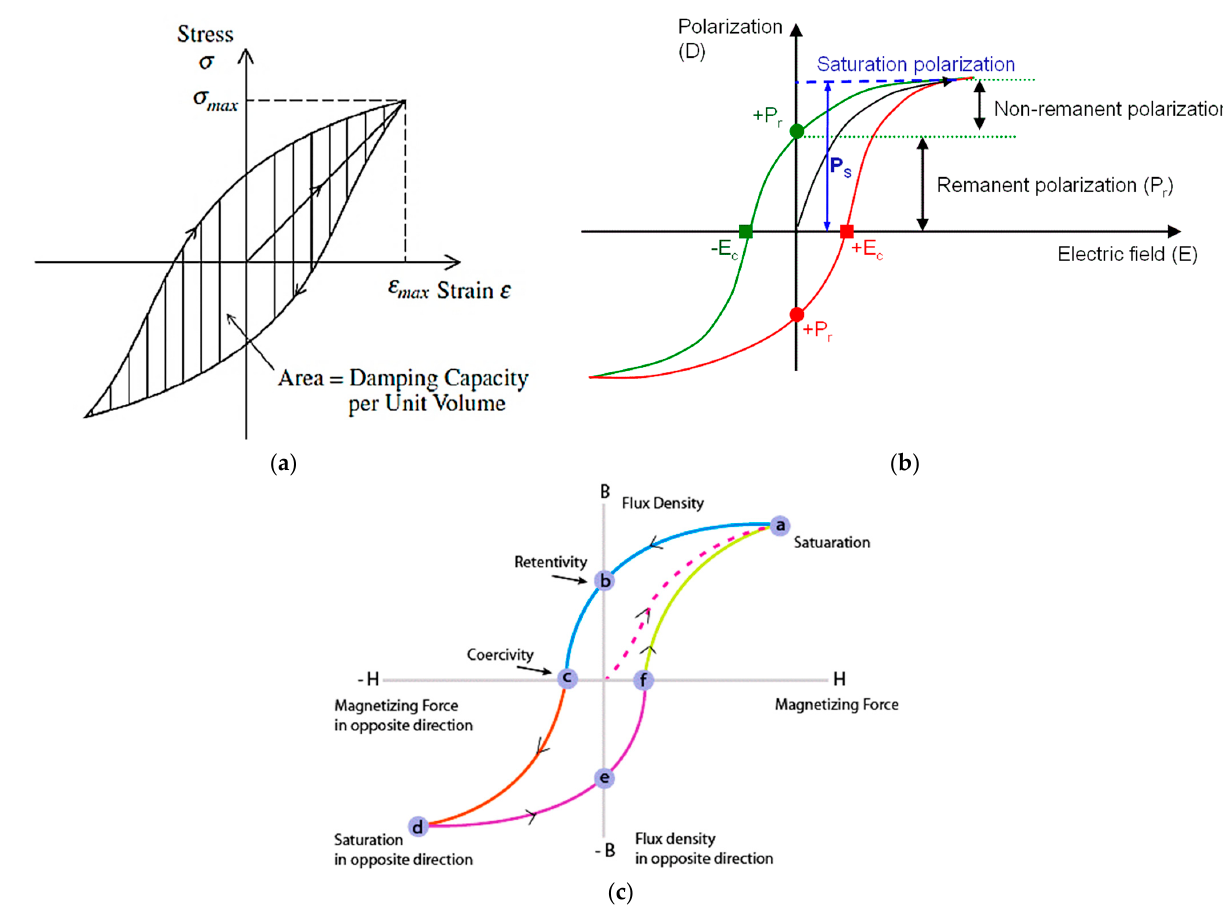
Figure 1. Hysteresis loop of different systems modeling: ( a ) Mechanical damping system; ( b ) Electrical system; ( c ) Magnetic system.